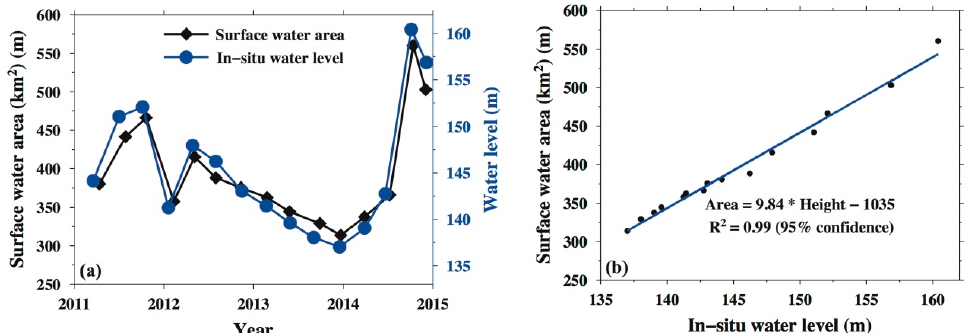
Figure 2. ( a ) Changes in the area and water levels in the DJKR (the red rectangular region in Figure 1); ( b ) linear regression model between the change in the area and water level.